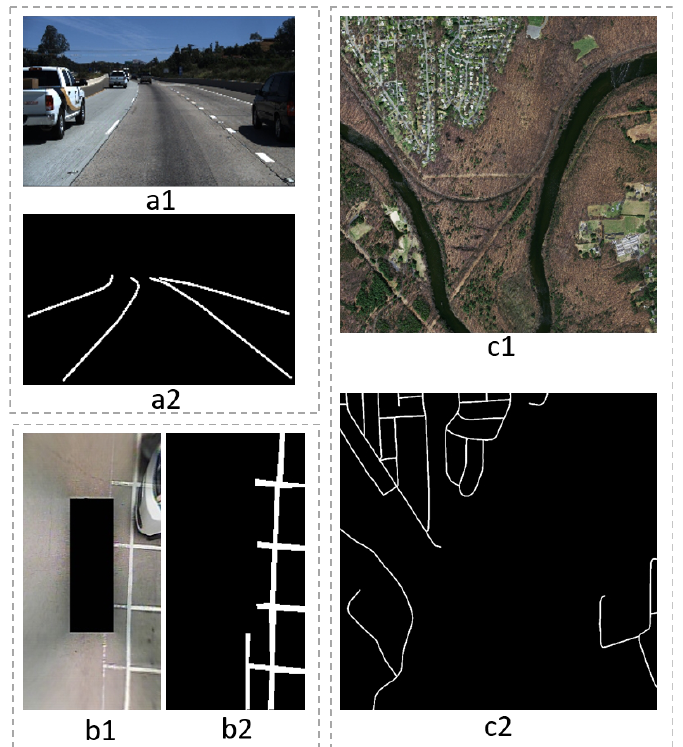
Figure 3. Example of the training dataset: a1 and a2 are the image and mask of TuSimple lane dataset, respectively; b1 is an image of the SS dataset, and b2 is a mask of b1 which only contain parking slot makers; c1 and c2 are the image and mask of the Massachusetts Roads Dataset,